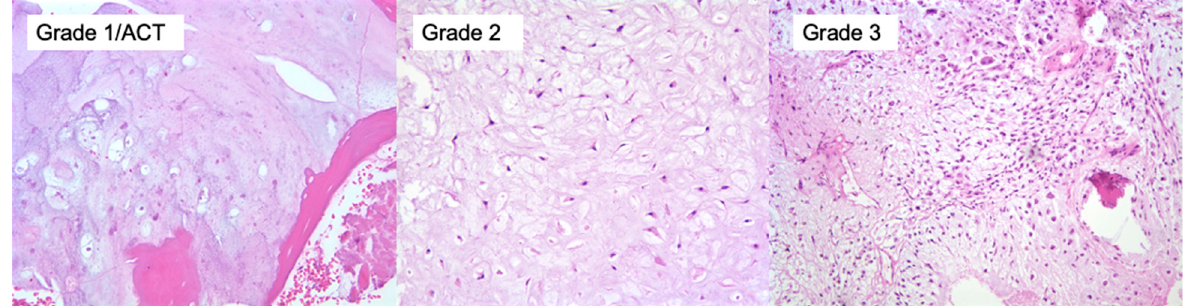
Figure 5. Microscopic images. Chondrosarcoma grading is based on the cellularity, cellular and nuclear pleomorphism/atypia and mitotic activity (H&E ×200). Grade 1/ACT is characterized by mild cellular atypia with small chondrocytes and nuclei. Grade 2 tumors are marked by increasing cellular atypia, increased nuclear size and binucleated cells. Grade 3 tumors are marked cellular atypia with nuclear enlargement and polymorphism.